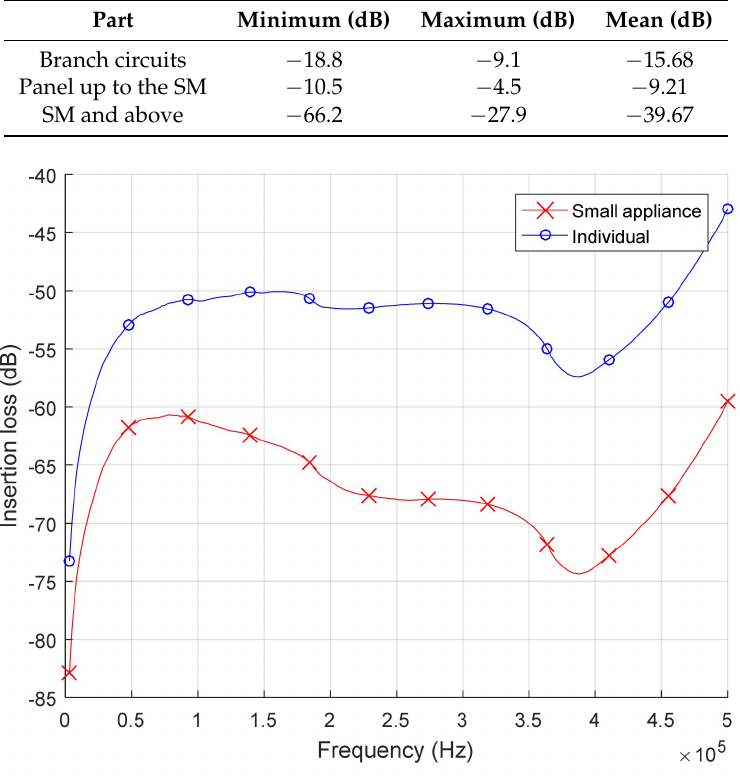
Figure 10. The average IL of the 9000 individual circuit channels and 8000 SA circuit channels in the 1000